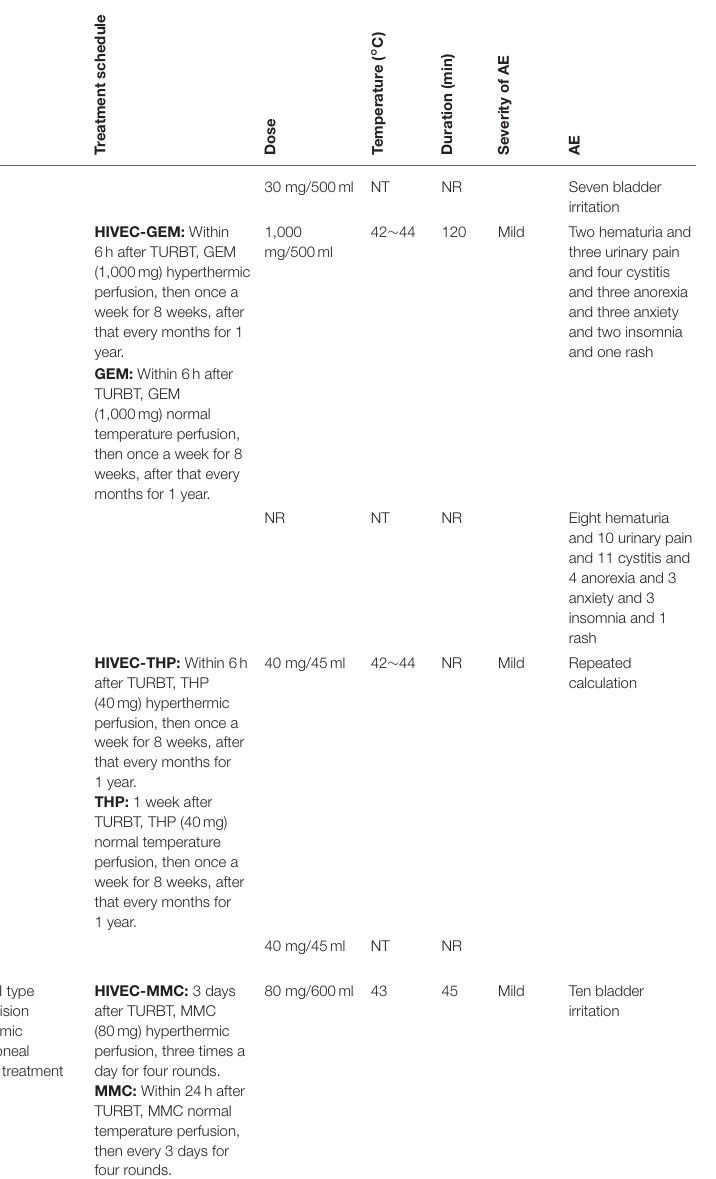
HIVEC-MMC: 3 days after TURBT, MMC (80mg) hyperthermic perfusion, three times a day for four rounds. MMC: Within 24h after TURBT, MMC normal temperature perfusion, then every 3 days for four